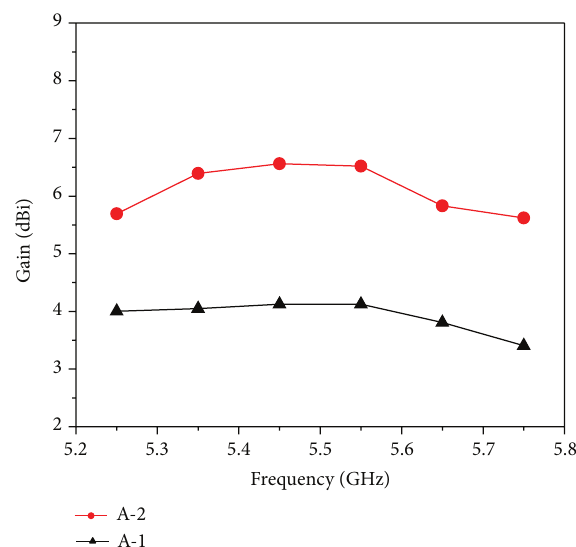
Figure 8: Measured peak gain versus frequency of the fabricated